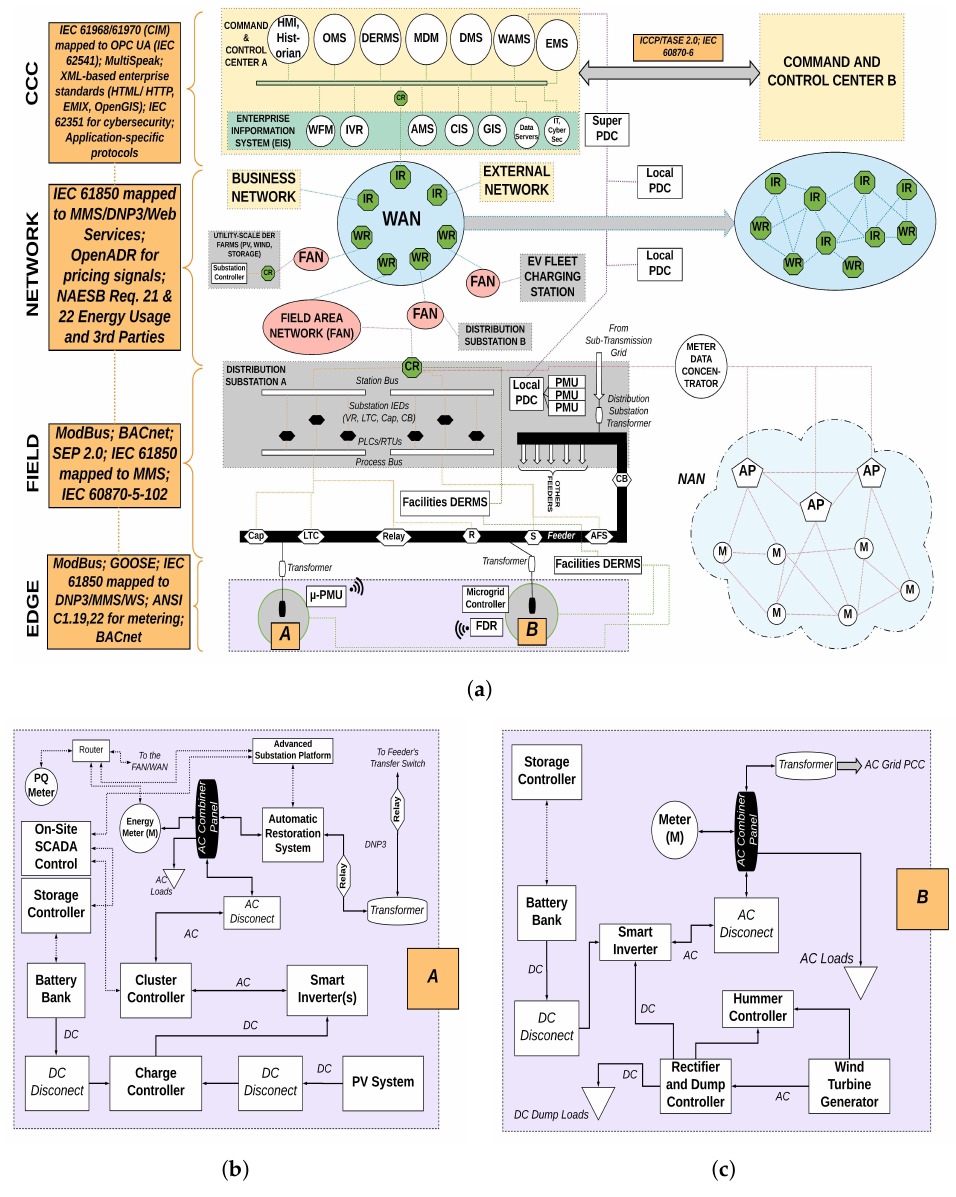
Figure 3. ( a ) The high-level conceptual architecture of distributed PV and Wind DERs communicating with a CCC, along with the different communications protocols mapped to each layer; ( b ) a detailed schematic of distributed PV (A); and ( c ) A detailed schematic of a distributed wind turbine (B). Dotted lines represent communications flows, and solid lines or larger arrows denote power